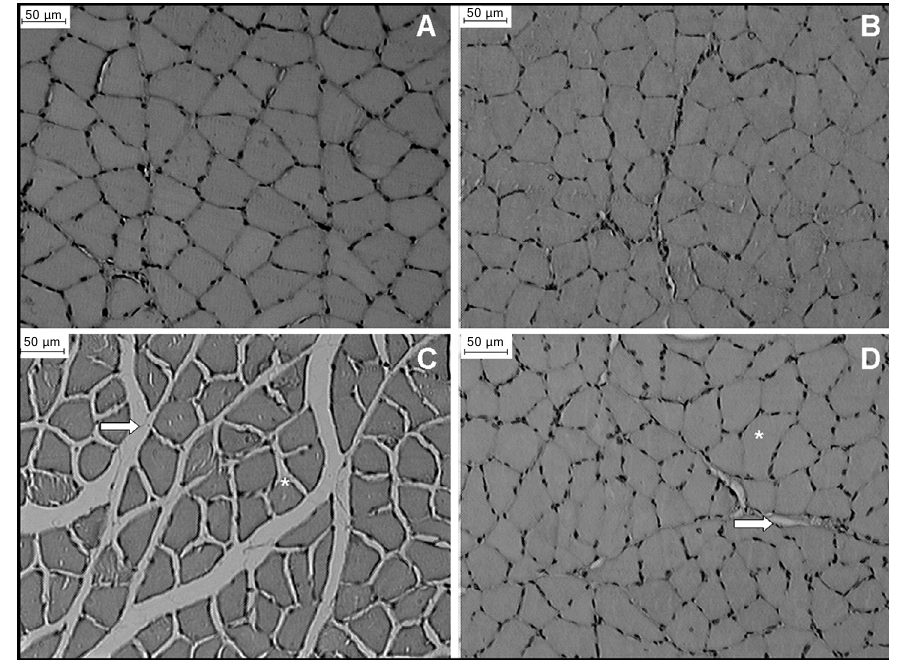
Figure 1. Soleus muscle fibers stained with hematoxylin and eosin. A, Control group. B, Clenbuterol treatment for 7 days. C, Immobilized in ankle neutral position for 7 days. A reduction of muscle fiber area (asterisk) and an increase of intramuscular connective tissue (arrow) can be seen compared with the control group. D, Immobilized and clenbuterol treatment for 7 days. An increase of muscle fiber area (asterisk) and a decrease of intramuscular connective tissue (arrow) can be seen compared with the immobilized group. Original magnification: